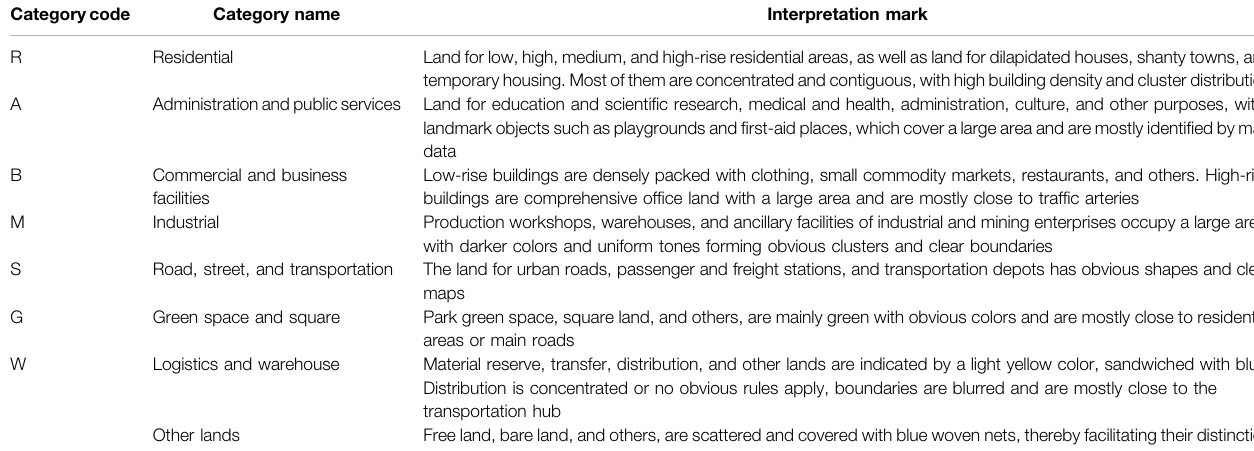
TABLE 2 | Interpretation marks of different types of land under remote sensing